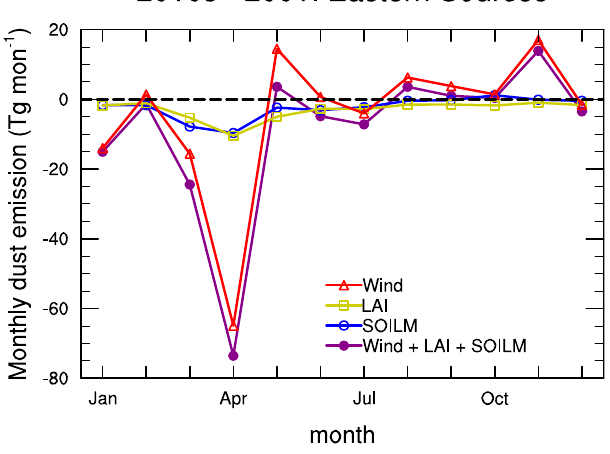
Fig. 3 | Monthly dust emission change during 2010 − 2017 (2010s) relative to 2001. Changes due to individual factors (surface wind –“ Wind ” , vegetation cov- er –“ LAI ” , soil moisture –“ SOILM ” ) and all the three factors together are depicted in red, yellow, blue, and deep magenta, respectively. The monthly changes are derived by calculating the dust emission change for each month from different model experiments (Table 1), as done in Fig. 1f. Note that summing the monthly changes for all the months yields the annual change shown in Fig.